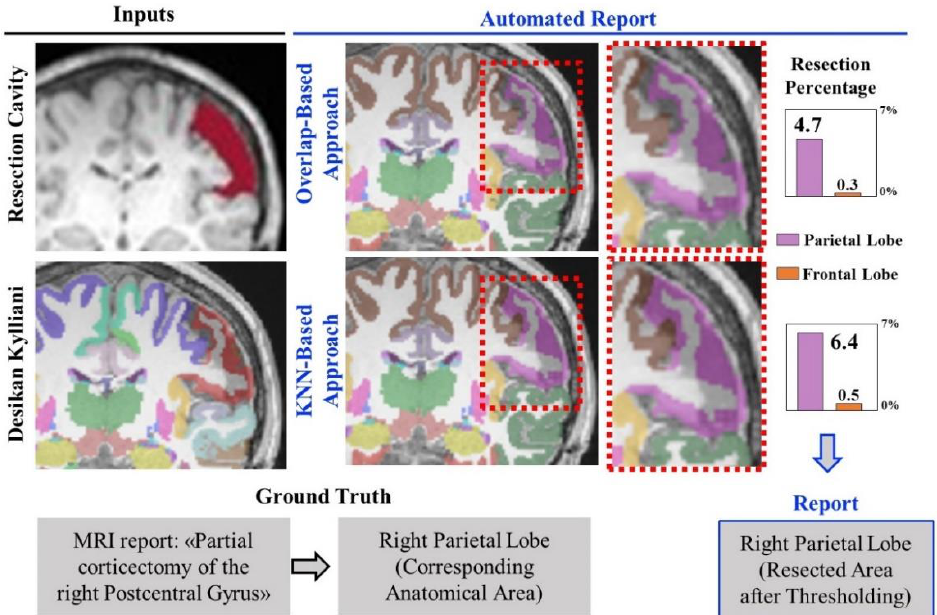
Figure 3. Automated generation of the resection anatomical report. Example of inputs (right: segmentation of the resection cavity, preoperative Desikan–Killiany cortical parcellation) and outputs (left: resection percentages of each anatomical area, and list of resected areas). Each cortical area of the Desikan–Killiany is associated with one anatomical area (frontal, temporal, parietal, occipital, cingulate, hippocampus, amygdala). Two approaches (overlap- and KNN-based) were used to estimate the resection percentage of each anatomical area and then generate an anatomical report, which was then validated by comparison with the ground truth (clinical MRI postsurgical report). In this example, both automated reports indicate right parietal lobe resection, consistently with the ground truth.